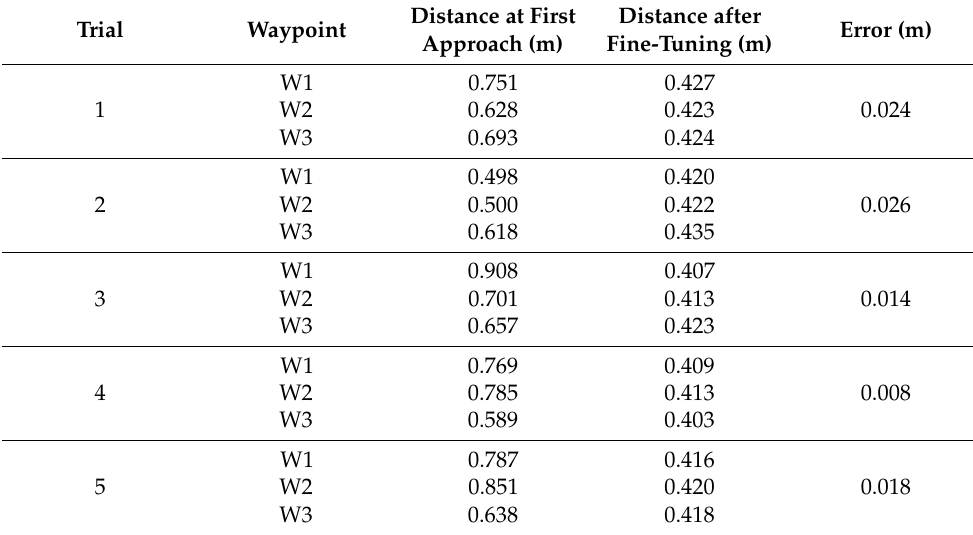
Table 2. Position errors measured during fine-tuned positioning for the first test